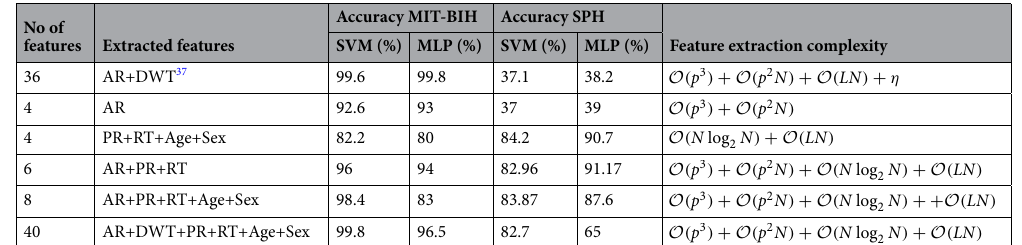
Table 3. The SVM and MLP classifier overall accuracy and computational complexity for the MIT-BIH and SPH databases using different sets of features.